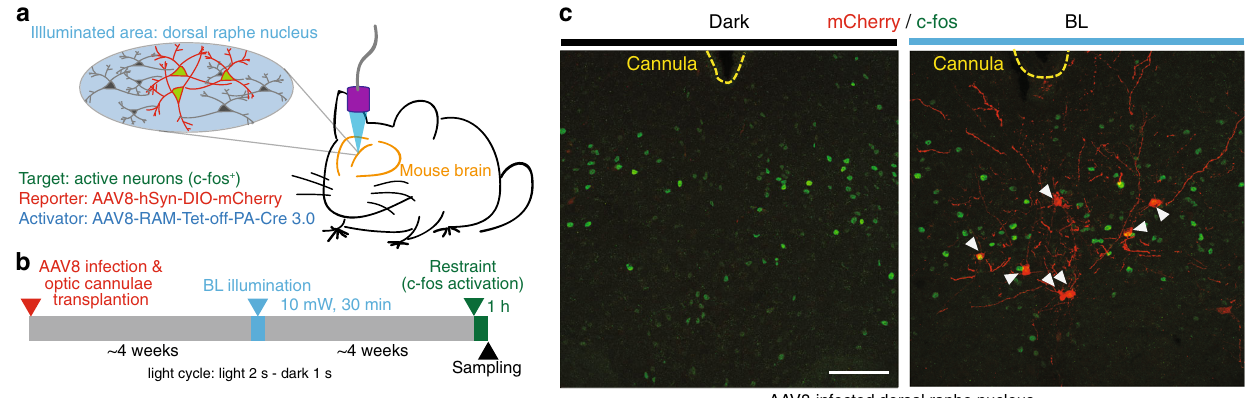
Fig. 4 PA-Cre 3.0 AAV in vivo applications in mice. a Schematic representation of AAV-RAM-Tet-off-PA-Cre 3.0 application for targeting active neurons in mouse dorsal raphe nucleus using RAM element and optic cannula. b Experimental time course of AAV-RAM-Tet-off-PA-Cre 3.0 application in mouse dorsal raphe nucleus with restraint, which can activate c-fos, and BL illumination. The mouse groups were kept in doxycycline-free condition. c Representative immuno fl uorescent images of red fl uorescent protein, mCherry (red) and neuronal activity marker, c-fos (green), in mouse dorsal raphe nucleus infected with AAV-RAM-Tet-off-PA-Cre 3.0 viruses in dark ( n = 2), and BL illumination ( n = 3). Optic cannulas are shown in yellow dashed lines. White arrowheads show c-fos- and mCherry-positive neurons in the area. Scale bar, 100 μ m.